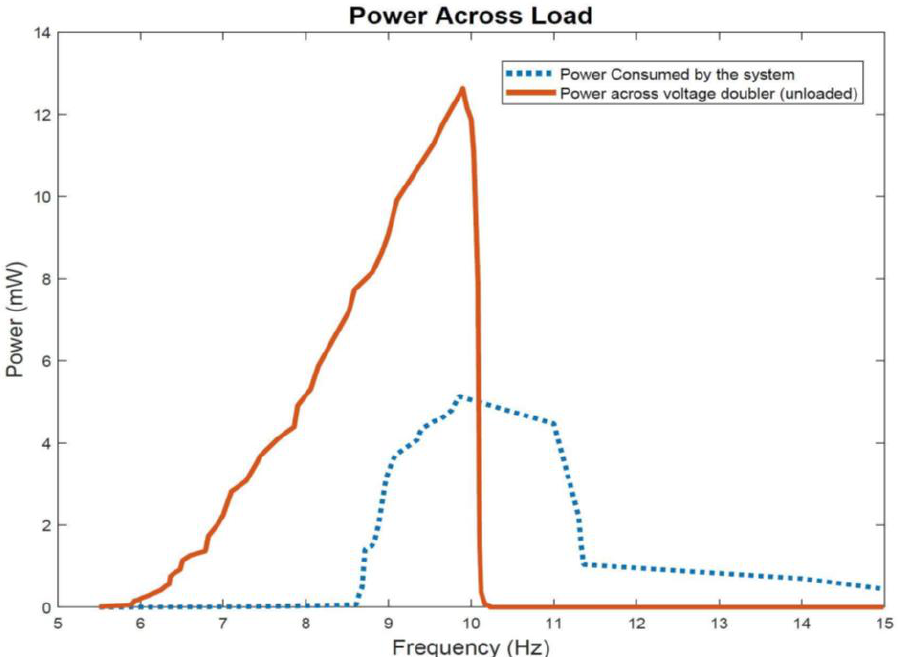
Figure 16. Power generated from the energy harvester at an unloaded voltage doubler output compared to power consumed by the microcontroller-transmitter subsystem load.